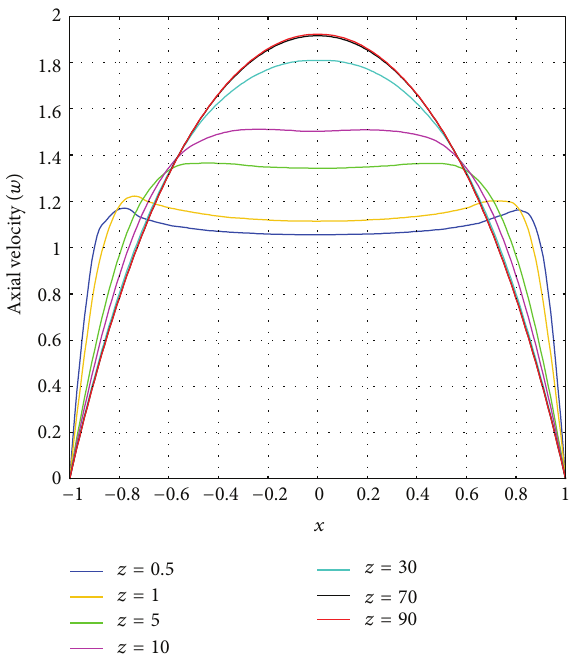
Figure 3: Steady flow development of axial velocity 𝑤 , at different axial position in the presence of magnetic field, when Re = 300 and Ha = 2 .